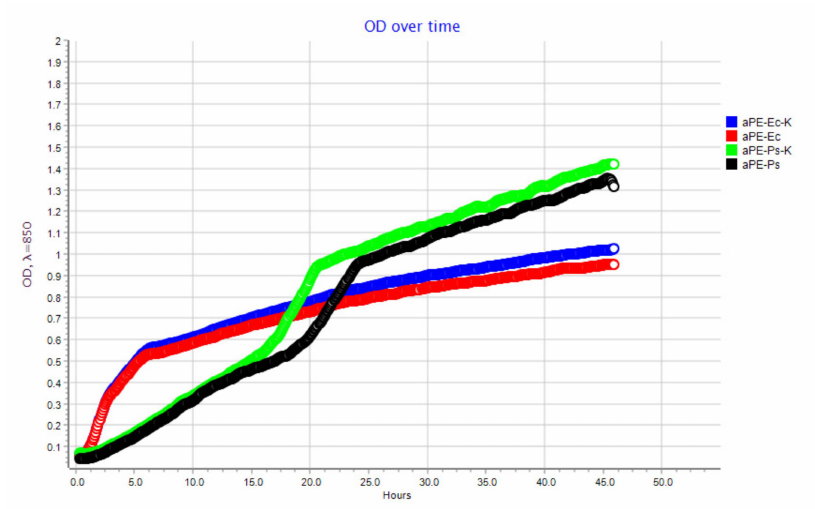
Figure 4. OD over time for E . coli and P. syringae after their incubation with the aPE; K—PE film; aPE—PE film containing a mixture of CO 2 extracts of raspberry seeds, pomegranate seeds, and rosemary in polymer matrix.